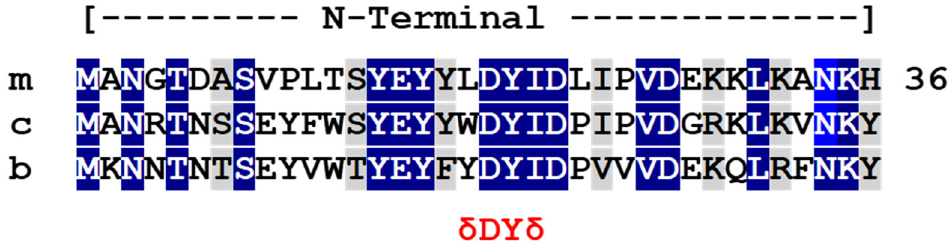
Figure 1. Multiple amino acid sequence alignment of the N-terminal domain of osteichthyan Mrap1s . Mrap1 sequences of mouse (m), chicken (c), and bowfin (b) were aligned, and primary sequence identity (highlighted blue) and primary sequence similarity (highlighted gray) were determined using BLOSUM (https://www.ncbi.nlm.nih.gov/Class/FieldGuide/BLOSUM62.txt) accessed on 6 August 2022. The overall sequence identity for the three orthologs was 44% and the overall sequence similarity was 64%. Each Mrap1 ortholog contained a putative a δ -D-Y- δ (activa- tion) motif [7].